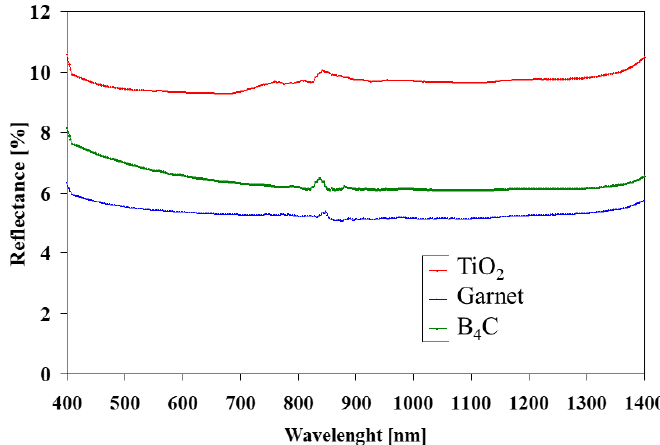
Figure 19. Optical reflectance of the plasma sprayed garnet.